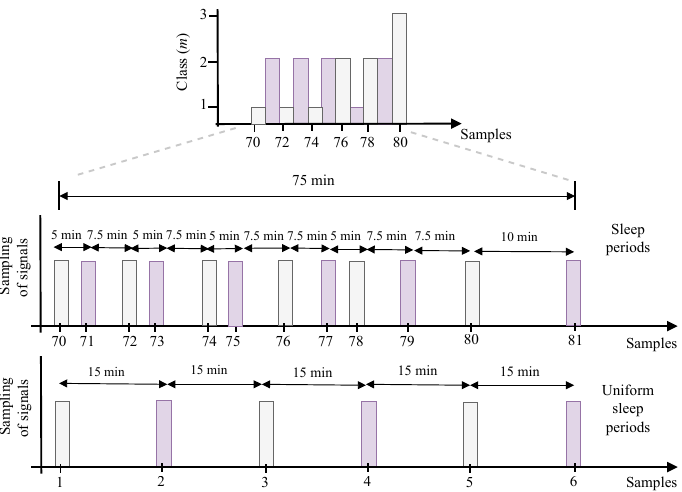
Figure 9. Comparative analysis result of ML-Decision tree and uniform power management for test scenario 1.